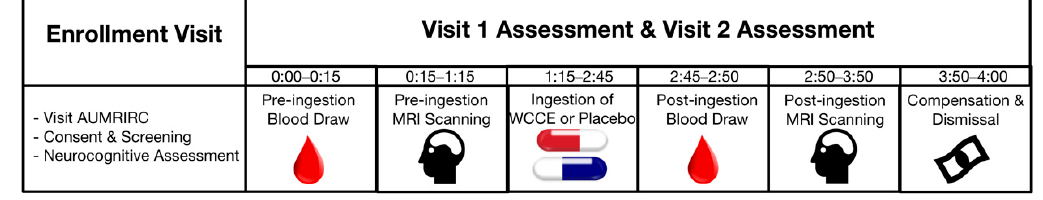
Figure 2. Study design overview. For the Visit 1 and Visit 2 Assessment, 0:00 indicates the participants arrival at the imaging center. Subsequent times indicate hours and minutes since arrival. AUMRIRC: Auburn University MRI Research Center.